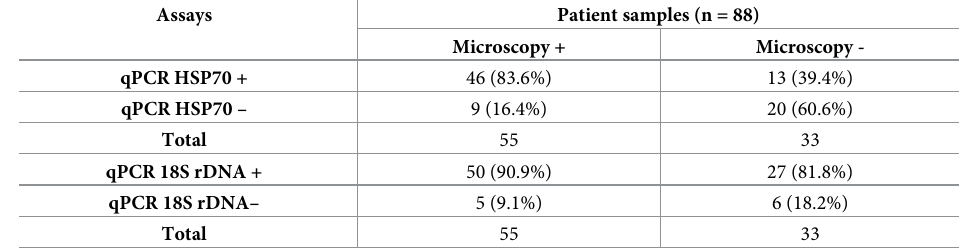
Table 5. Sensitivity and specificity of Leishmania detection by real time PCR (qPCR) in comparison to microscopy. Assays Patient samples (n = 88) Microscopy + Microscopy - qPCR HSP70 + 46 (83.6%) qPCR HSP70 – 20 (60.6%) Total qPCR 18S rDNA + qPCR 18S rDNA– Total Sensitivity and specificity values for qPCR assays using the 18S rDNA and HSP70 targets in comparison to microscopy were obtained for the 88 patient samples